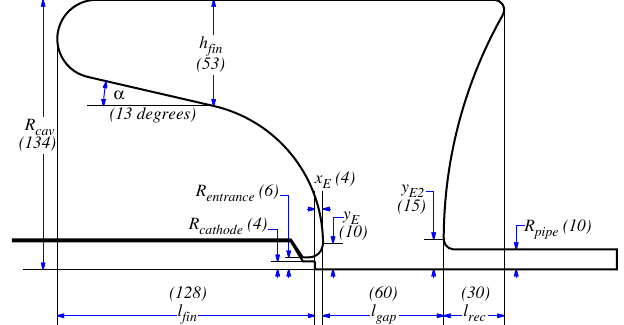
FIG. 4. Diagram of gun geometry with parameters and quan- tities. Quantities are rounded to the nearest millimeter and given in millimeters, except where explicitly indicated.